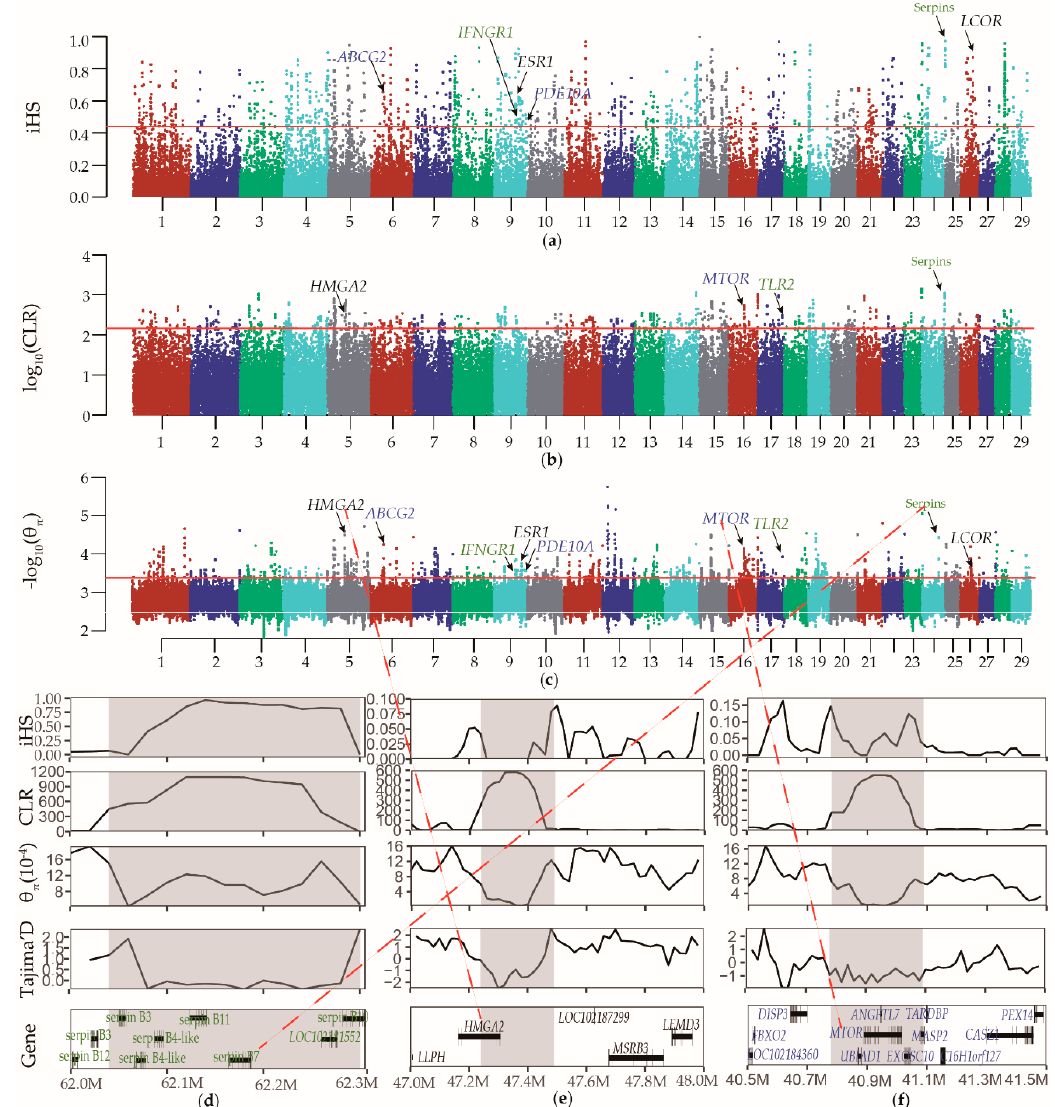
Figure 3. Identification of selective signals in the Du’an goat. Distribution of iHS statistic ( a ), composite likelihood ratio (CLR) statistic ( b ), and nucleotide diversity ( c ) in a 50 kb sliding window with a 20 kb step across all autosomes. The red lines indicate the corresponding threshold (iHS statistic > 0.4424167, CLR statistic > 148.2987 and nucleotide diversity < 0.0004230301). ( d ) Selective sweep at the serpin cluster on chromosome 24 (62.04–62.33 Mb) (gray area). ( e ) Selective sweep at the HMGA2 on chromosome 5 (47.24–47.49 Mb) (gray area). (annotation, black rectangles and black lines represent exons and introns, respectively. ( f ) Selective sweep at the MTOR on chromosome 16 (40.78–41.09 Mb) (gray area). In gene.